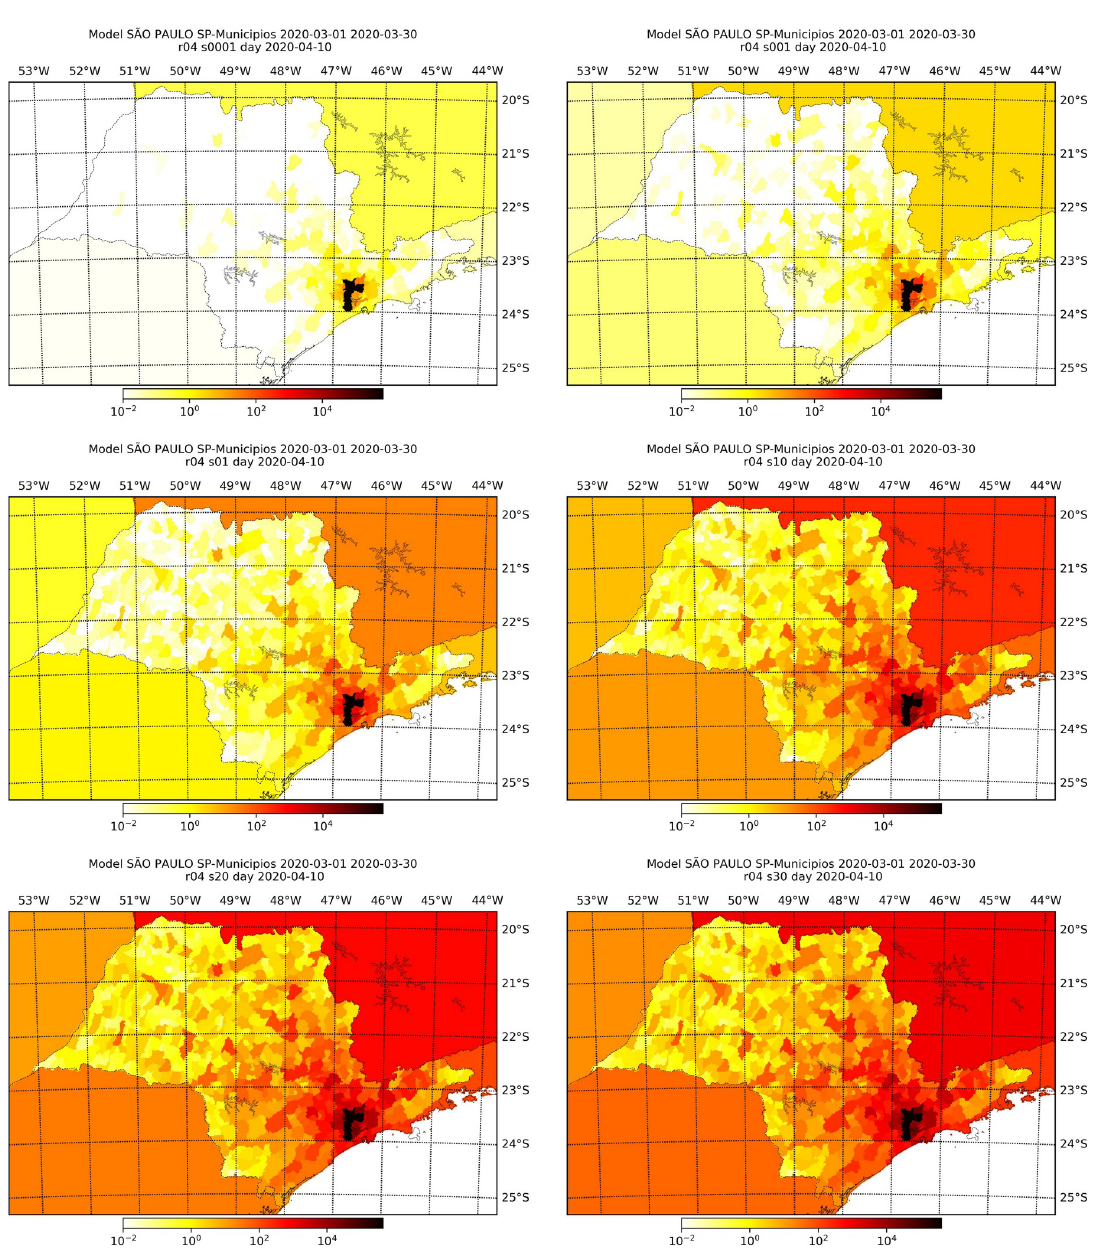
Fig 7. Simulation results at the 10th of April for the number of infected individuals in the state of S ã o Paulo considering different values of s , namely, 0.0001 (top left), 0.001 (top right), 0.1 (mid-left), 1.0 (mid-right), 2.0 (bottom-left) and 3.0 (bottom-right).